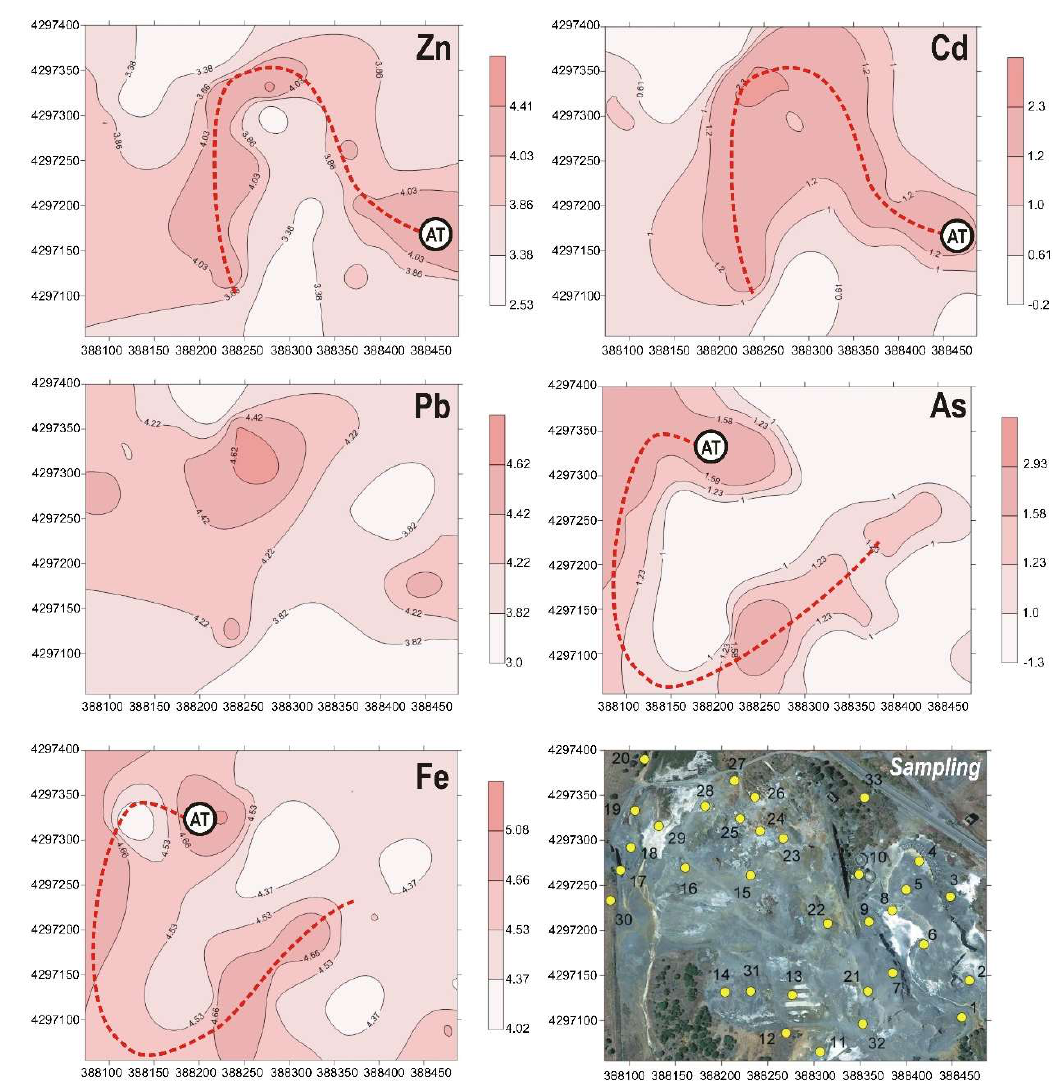
Figure 5. Kriging maps for Zn, Cd, Pb, As, Fe, and sampling location map. AT: Axial trend of the anomalies. Graphics: STATGRAPHIC Centurion version XVII. Note the striking spatial similarities of trends for the Zn–Cd and As–Fe pairs.